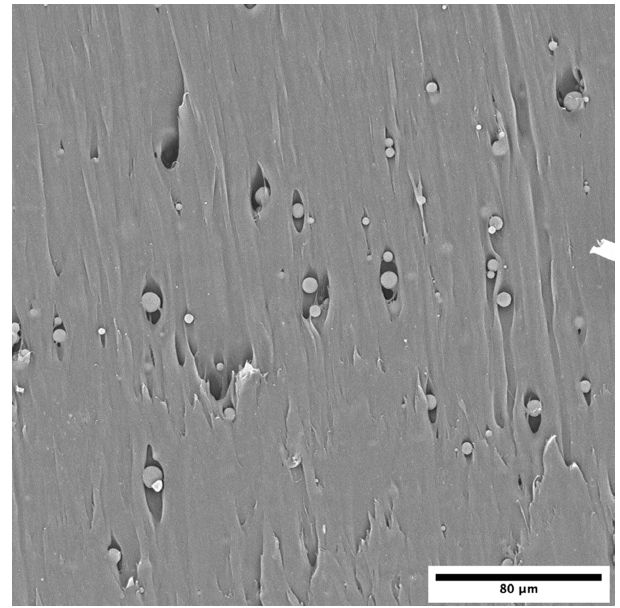
Figure 2. SEM image of MHP embedded in epoxy resin. The sample was fractured under liquid nitrogen, in order to show internal vesiculation of particles (magnification: ( a ) 5000 × , ( b ) 15,000 × ).